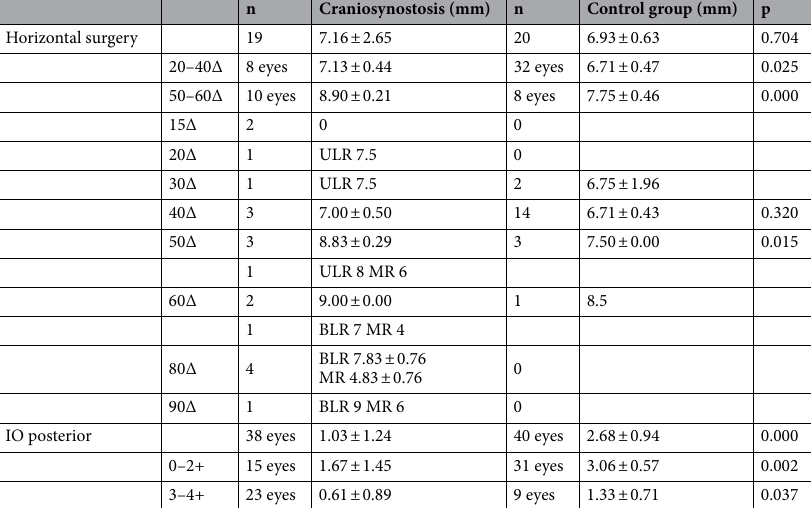
Table 2. Comparison of the operation between craniosynostosis and control group. ULR unilateral lateral recession, BLR bilateral lateral rectus recession, MR medium rectus resection.